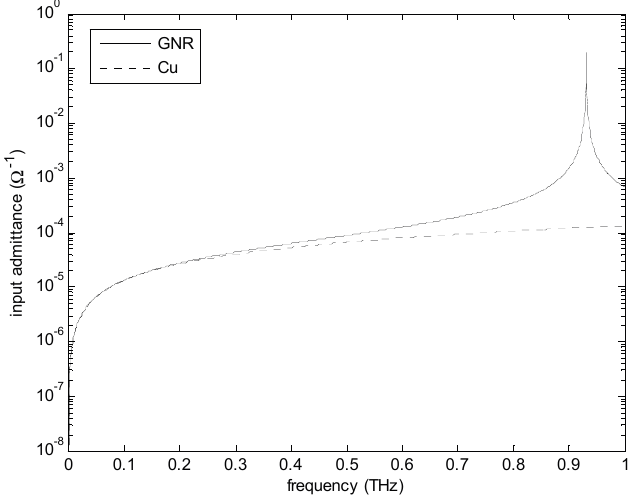
Figure 4. Plasmon resonance in the input admittance of the detector in Figure 1, with a GNR of length 1 μ m, compared to the case of Cu electrodes